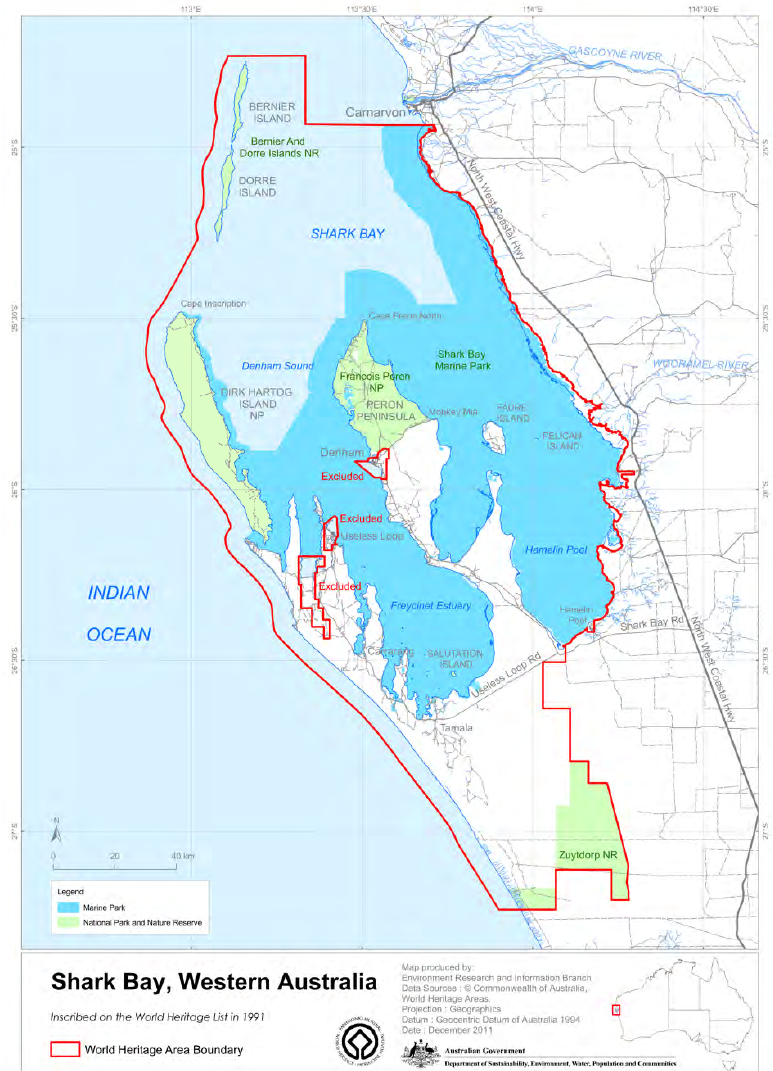
Figure 2.1 Map of Shark Bay, Western